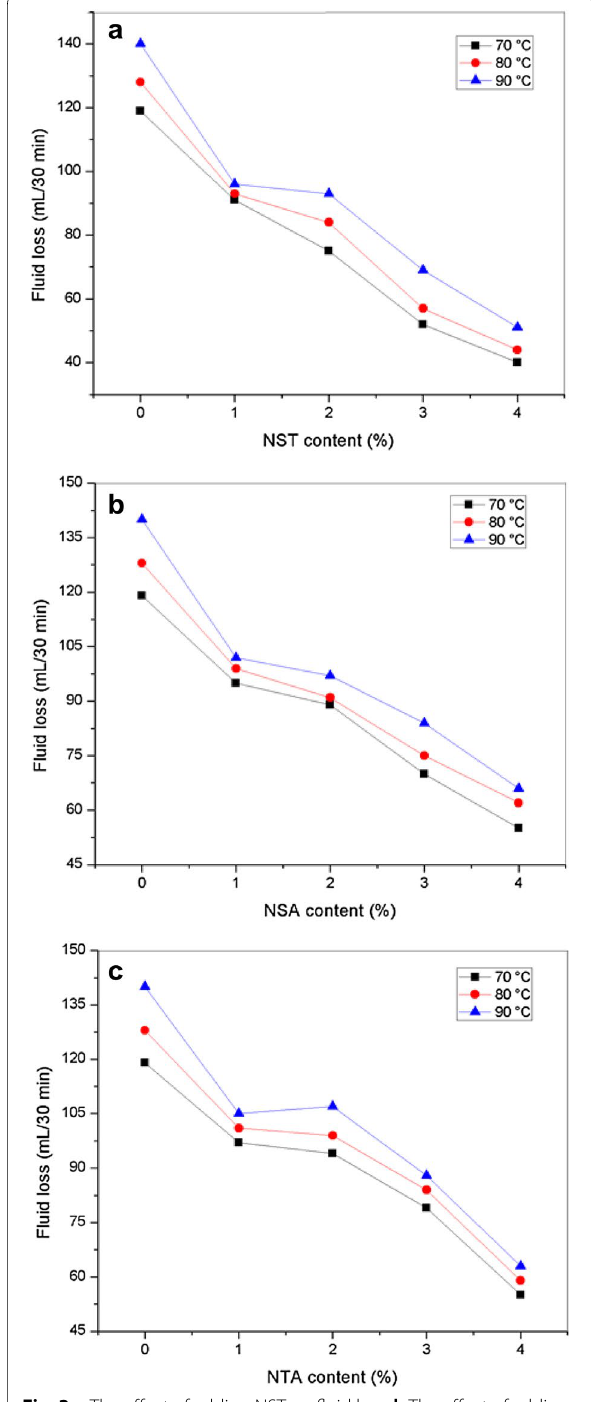
Fig. 3 a The effect of adding NST on fluid loss. b The effect of adding NSA on fluid loss. c The effect of adding NTA on fluid